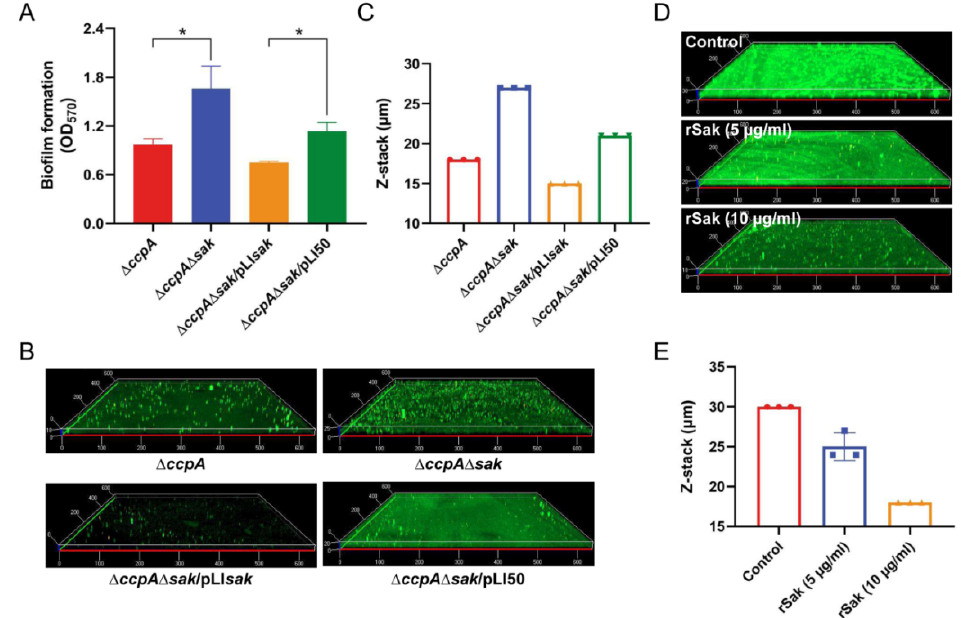
Figure 5. CcpA-controlled Sak regulates biofilm formation. ( A ) Assessment of biofilm formation. Biofilms were cultivated in TSB + G medium under static conditions for 24 h, and quantified via crystal violet staining. The data are expressed as the mean ± SD from three independent replicates. *, p < 0.05. ( B ) CLSM of biofilm formation. ∆ ccpA and derivatives differing in Sak production were cultivated in TSB + G medium, stained with FITC-ConA and PI, and visualized by CLSM. Representative images from one of three replicates are shown. ( C ) Statistics of the biofilm thickness from ( B ) The data are expressed as the mean ± SD from triplicate. ( D ) CLSM of biofilm formation upon exogenous rSak treatment. S. aureus strain XN108 was cultured in TSB + G medium supplemented with different concentrations of rSak (0, 5, 10 µg/mL), and formed biofilms were assessed by CLSM. Representative images from one of three replicates are shown. ( E ) Statistics of the biofilm thickness from ( D ). The data are expressed as the mean ± SD from triplicate.